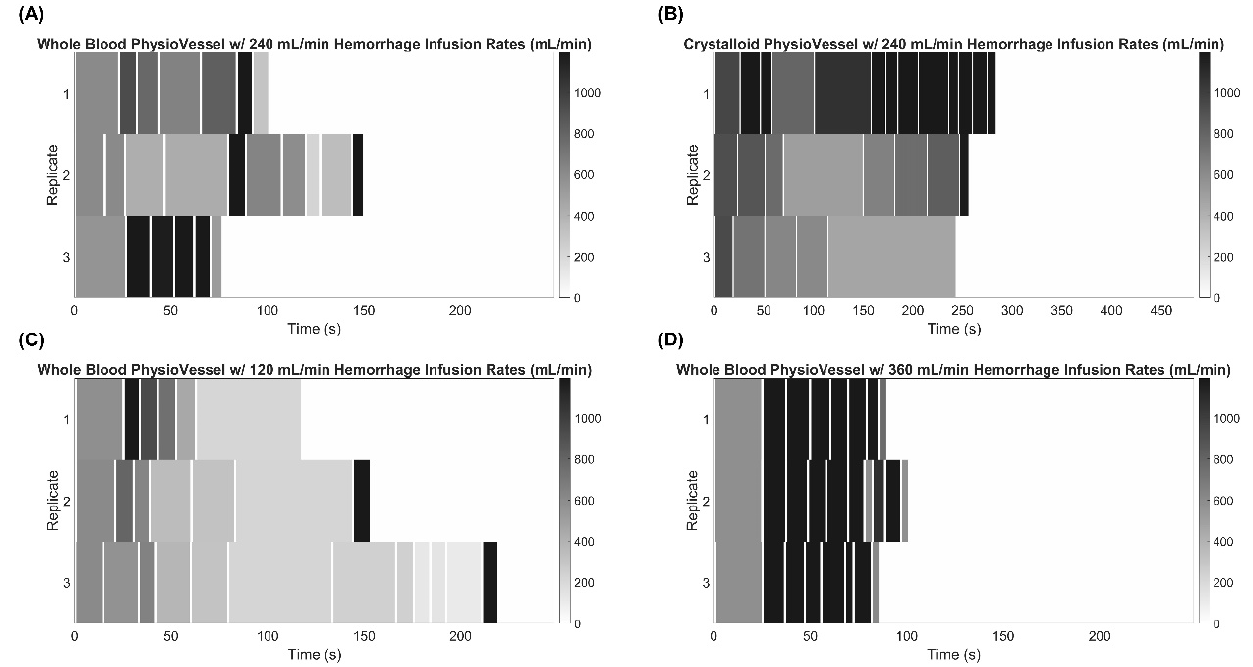
Figure 4. Effect of internal hemorrhage on the Adaptive Resuscitation Controller (ARC). Flow rate determined by ARC vs. time starting after initial hemorrhage to approximately 75 mmHg until the target of 95 mmHg was reached with a continuous internal hemorrhage as indicated. Results are shown for an internal hemorrhage rate of 240 mL/min during resuscitation using ( A ) PV WB and ( B ) PV C , ( C ) 120 mL/min hemorrhage rate using PV WB , or ( D ) 360 mL/min hemorrhage rate using PV WB . Three technical replicates are shown as separate rows to illustrate how step sizes and flow rate changes varied. Heat map intensities range from 1200 to 0 mL/min for each, and time axes are equal for corresponding PV models to highlight the difference in rates to stabilize.